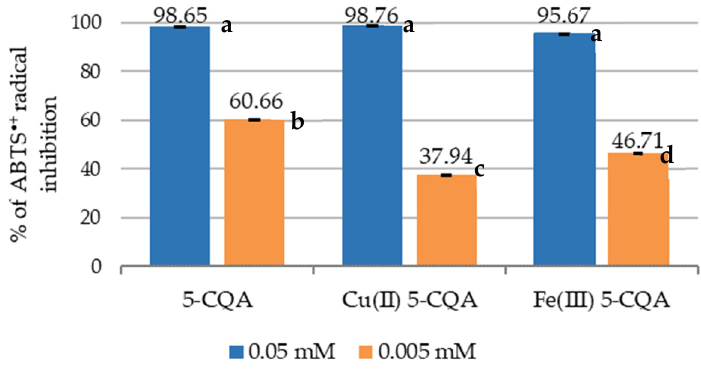
Figure 9. Antioxidant properties of 5-CQA, Cu(II) 5-CQA, and Fe(III) 5-CQA (0.05 and 0.005 mM) expressed as the ability to scavenge ABTS • + cation radicals (%I). Mean values from three independent experiments ± SDs are shown. The same letter near the means indicates no significant difference (Tukey’s test, p < 0.05).